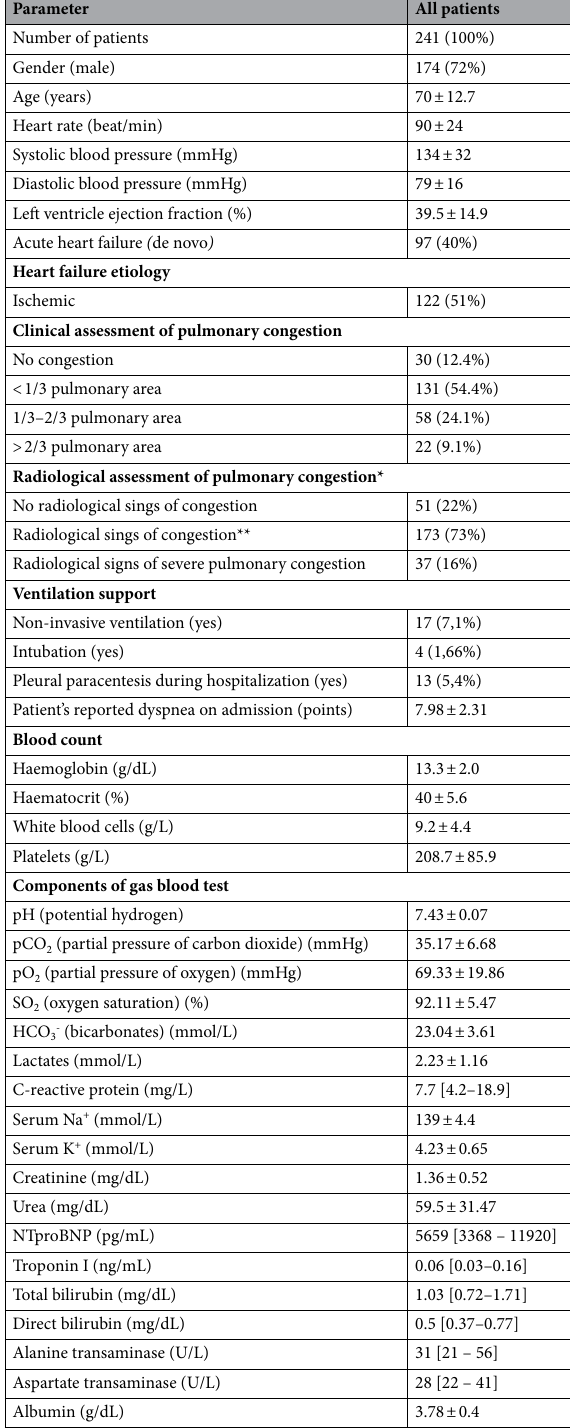
Table 1. Baseline characteristics. *Data available in n = 237. **Defined as pleural effusion, any signs of congestion not classified as radiological signs of pulmonary